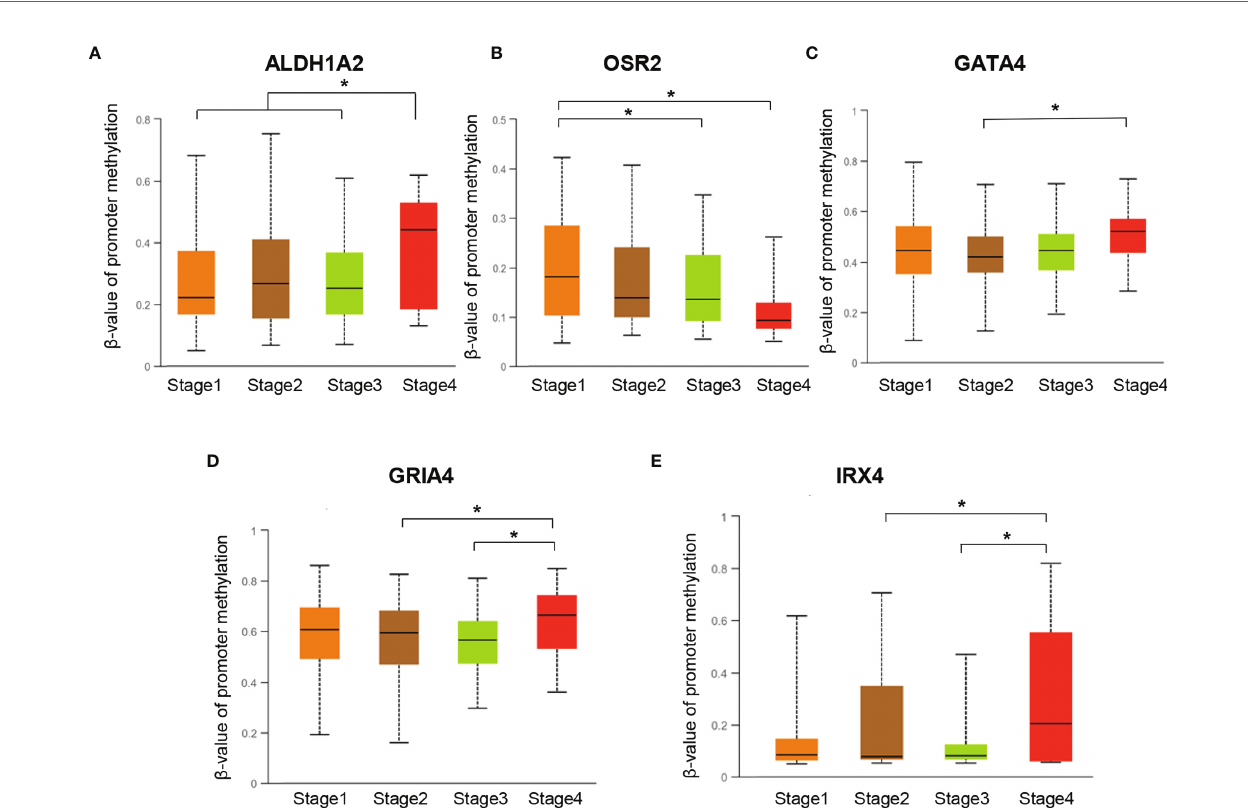
FIGURE 3 | Promoter DNA methylation levels of ALDH1A2 (A) , OSR2 (B) , GATA4 (C) , GRIA4 (D) , and IRX4 (E) were compared among the patients with different clinical-stages, * P <